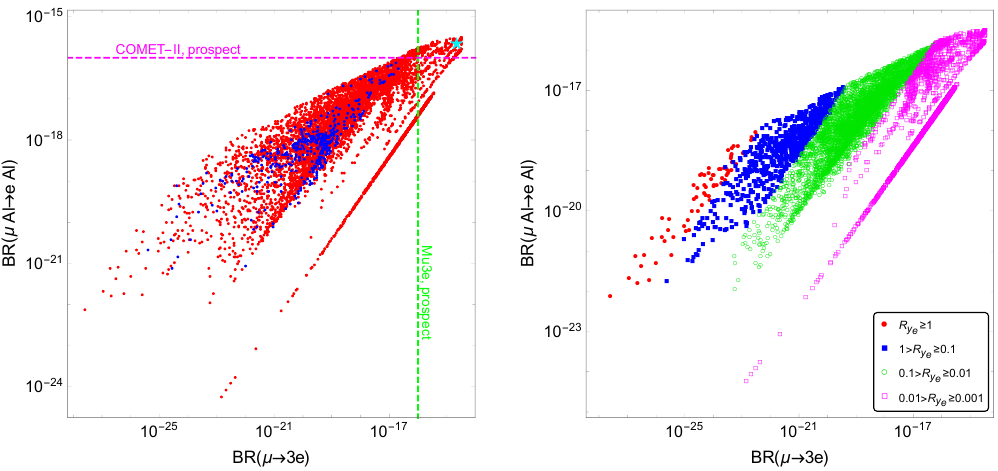
Figure 4 . Left: correlation between our predictions of BR( µ → 3 e ) and BR( µN → eN ) with m H = 170 TeV. The color manner is the same as in figure 2, and the magenta dashed line is the expected future sensitivity of BR( µ Al → e Al ) [99]. Right: the plot for the tuning level in the same plane as the left. We use the same data as in figure